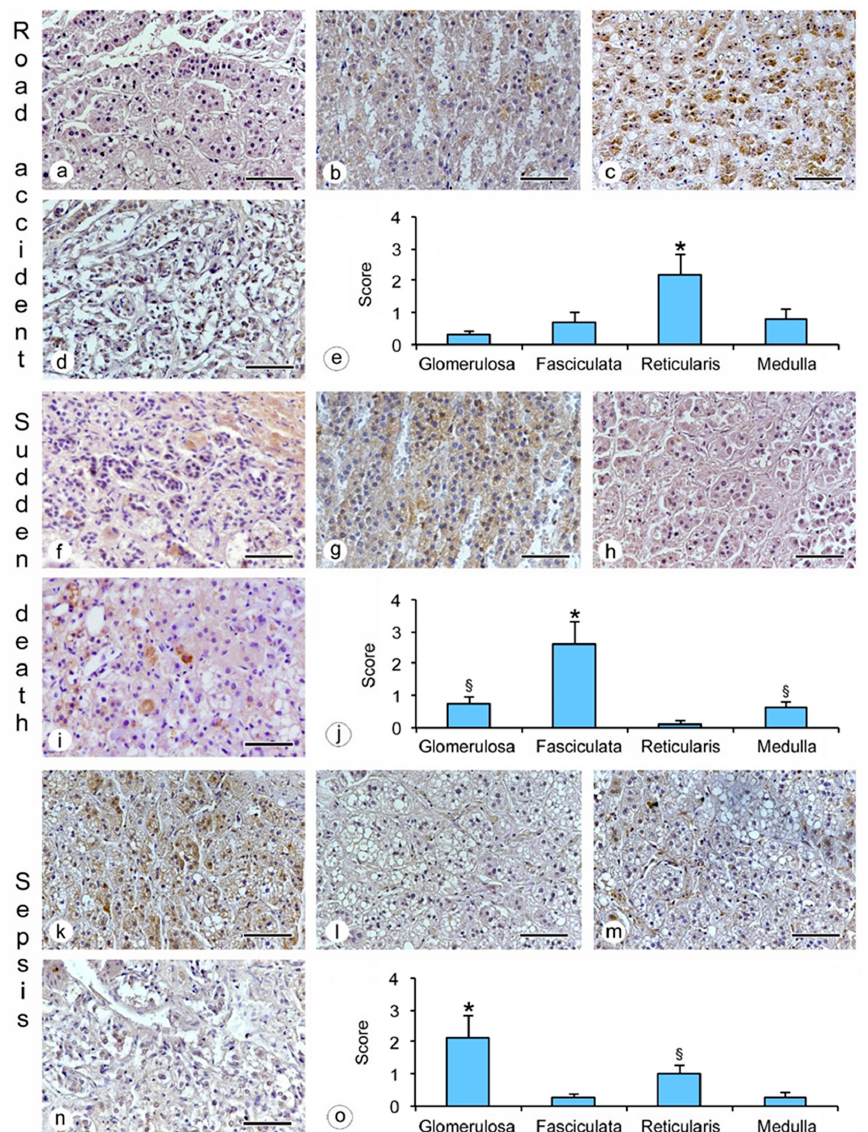
Figure 2. β 2-adrenergic receptor (AR) expression in cases of road accidents, sudden death and sepsis in the different zones of the adrenal gland. a , f , k = glomerulosa zone; b , g , l = fasciculata zone; c , h , m = reticularis zone; d , i , n = medulla; e = levels of immunohistochemical expression in the different zones of the adrenal gland of subjects from the road accident group based on the arbitrary score used. * = p < 0.05 versus glomerulosa and fasciculata zones and medulla; j = levels of immunohistochemical expression in the di ff erent zones of the adrenal gland of subjects from the sudden death group based on the arbitrary score used. * = p < 0.05 versus glomerulosa and reticularis zones and medulla, § = p < 0.05 versus reticularis zone; o = levels of immunohistochemical expression in the di ff erent zones of the adrenal gland of subjects from the sepsis group based on the arbitrary score used. * = p < 0.05 versus fasciculata and reticularis zones and medulla, § = p < 0.05 versus fasciculata zone and medulla. Scale bar = 100 µ